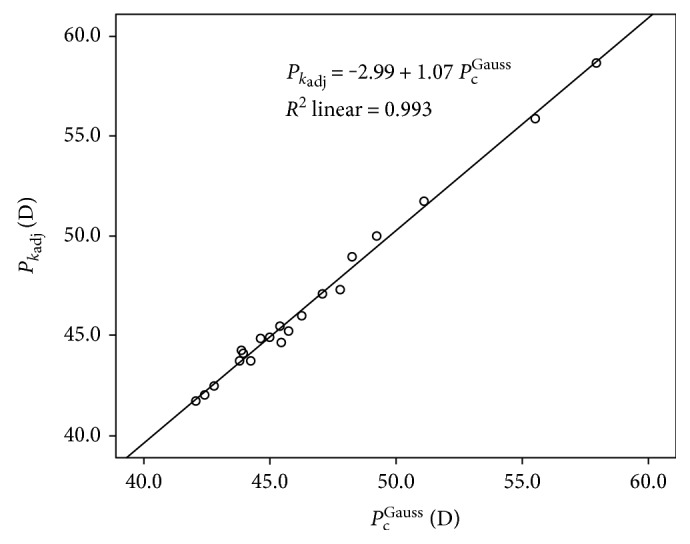
Scatterplot showing the relationship among adjusted keratometric (Pkadj) and Gaussian (PcGauss) corneal power. The adjusting line to the data obtained by means of the least-squares fit is shown.